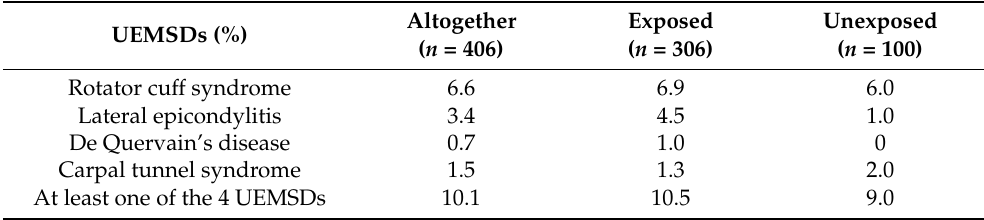
Table 4. Frequency of clinically diagnosed upper extremity musculoskeletal disorders (UEMSDs) according to the exposure